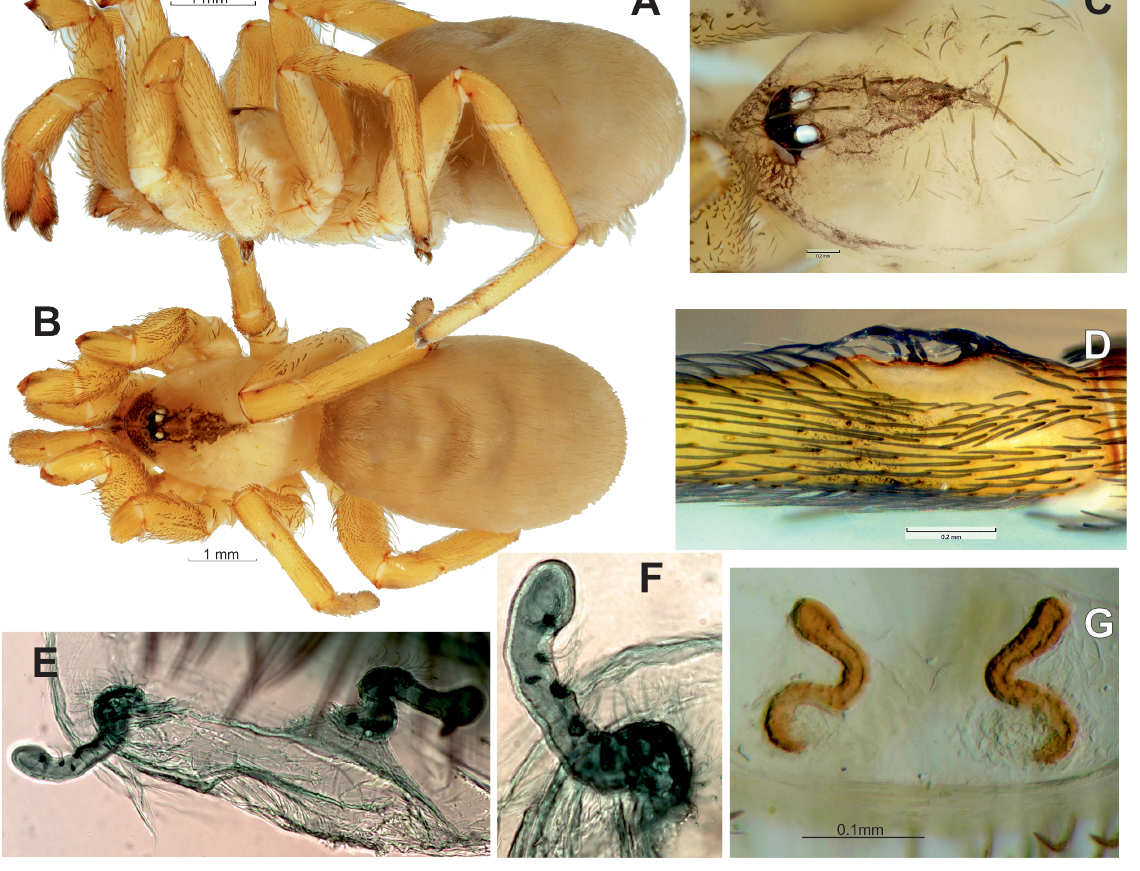
Fig. 15. Somatic characters and endogyne of Zaitunia akhanii Marusik & Zamani, 2015, holotype, ♀ . A–B . Habitus, lateral and dorsal. C . Prosoma, dorsal. D . Calamistrum lateral. E , G . endogyne, dorsal. F . Left receptacle, ventral. Scale bars: a–B = 1.0 mm; C–D = 0.2 mm; G = 0.1